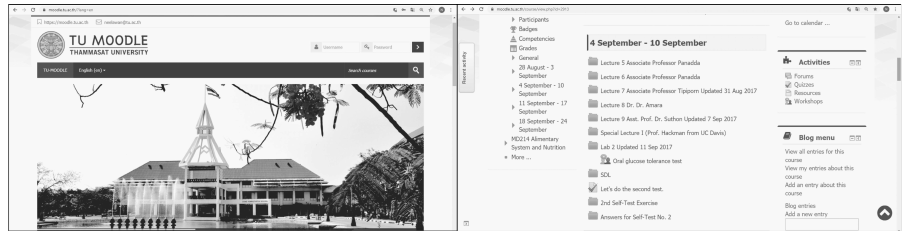
Figure 1. Left: screenshot of Moodle homepage (https://moodle.tu.ac.th/? lang=en); Right: screenshot of MD 314 Endocrine System of the 2017 curriculum